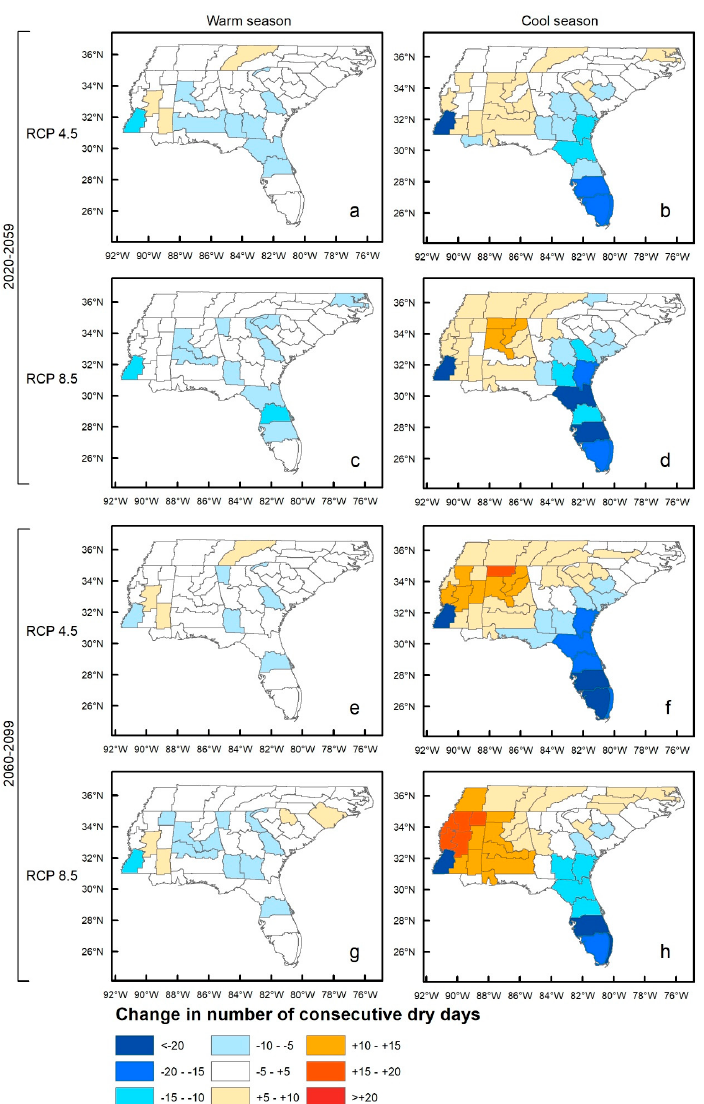
Figure 3. Absolute changes in length of 20-year return period consecutive dry days in modeled future periods versus observations. Warm season estimates are shown in ( a , c , e , g ), and cold season estimates are shown in ( b , d , f , h ). Future period and RCP scenario are indicated on the left.